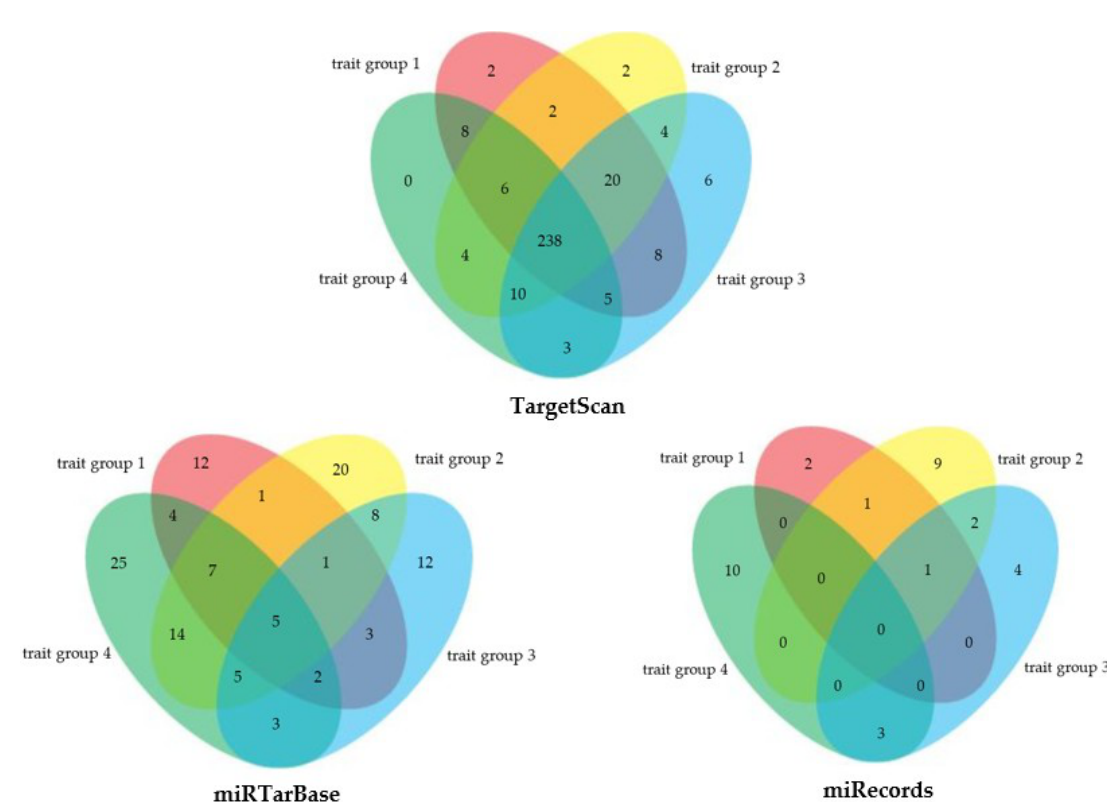
Figure 3. The distribution of cardiometabolic disease‐associated miRNAs by trait group. Approximately 74.8% of cardiometabolic miRNAs in TargetScan were predicted to regulate genes that, altogether, associated with four cardiometabolic trait groups. Five pleiotropic miRNAs in miRTarBase were among 238 pleiotropic miRNAs in TargetScan. Trait group 1, coronary artery disease and blood pressure traits; trait group 2, lipid traits; trait group 3, anthropometric traits; trait group 4, type 2 diabetes and glycaemic traits.